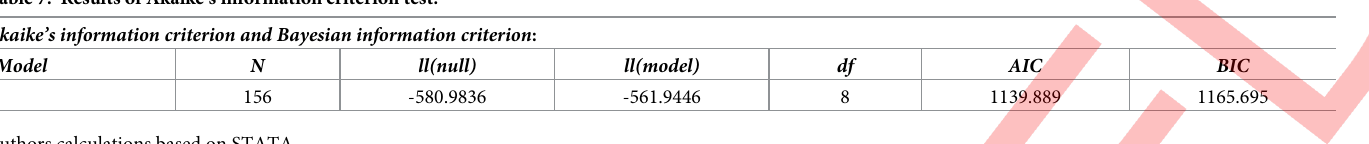
Table 7. Results of Akaike’s information criterion